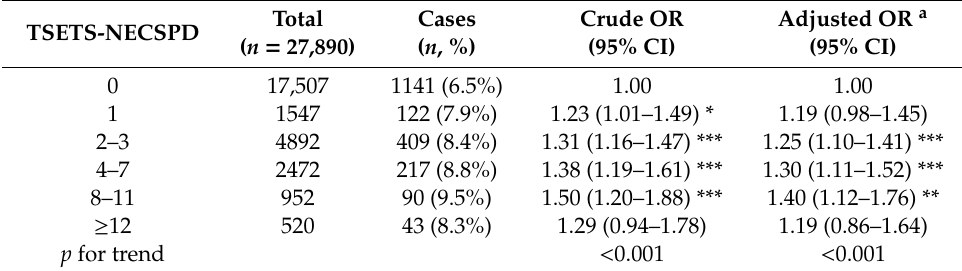
Table 2. The dose-response relationship between total score of ETS exposure based on the number of exposing cigarettes smoked per day (TSETS-NECSPD) and astigmatism. TSETS-NECSPD